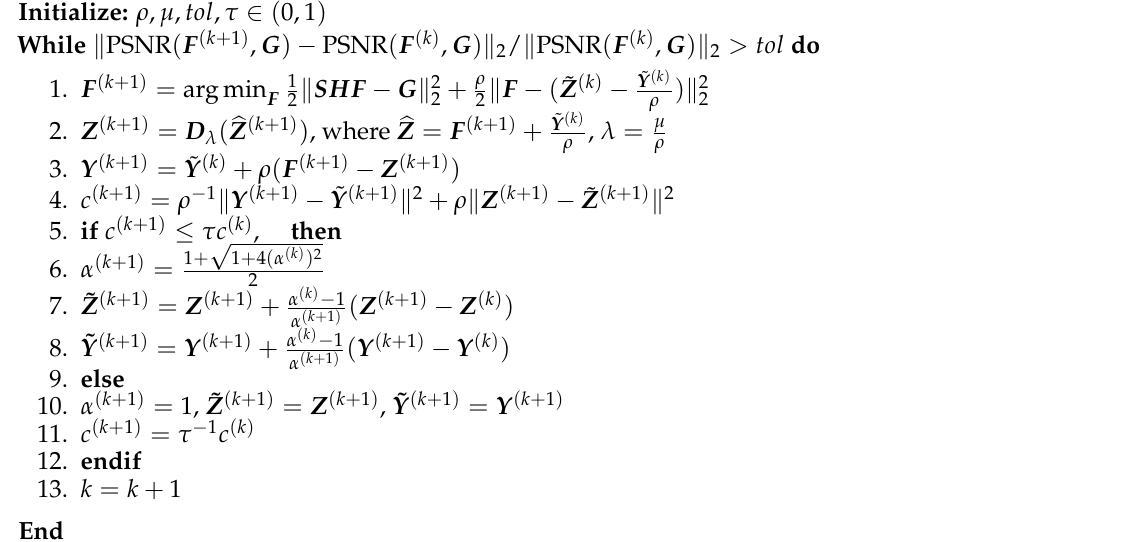
Algorithm 2 Super-resolution using the fast plug-and-play